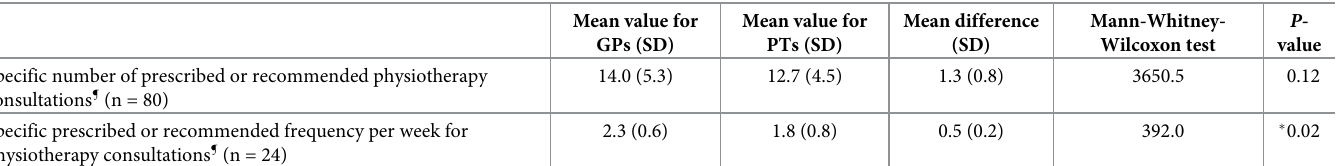
Mean value for Mean value for Mean difference Mann-Whitney- P - GPs (SD) PTs (SD) (SD) Wilcoxon test